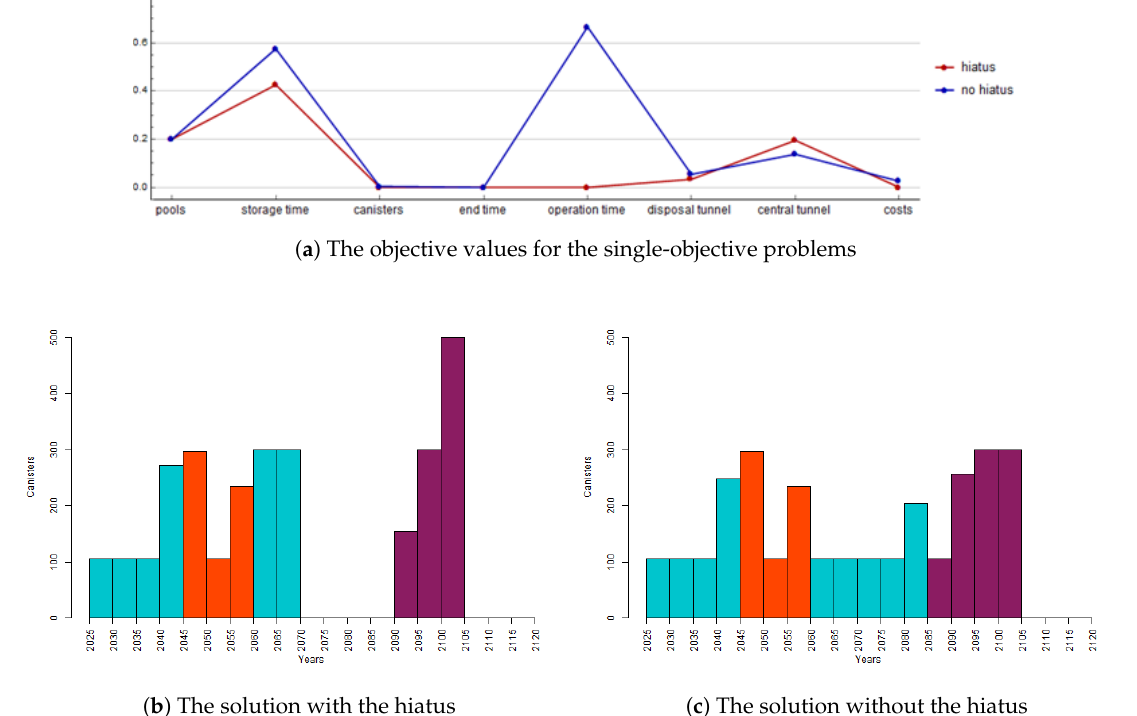
Figure 4. Results for the single-objective